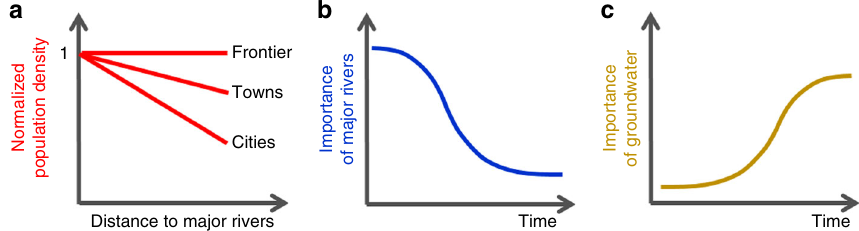
Fig. 2 The hypotheses tested in this study. a Hypothesized relationship between normalized population density (NPD) and distance to major rivers (DMR), and their temporal trends associated with the development of settlements from frontier, to towns, and to cities, in pre-industrial societies. The dynamics